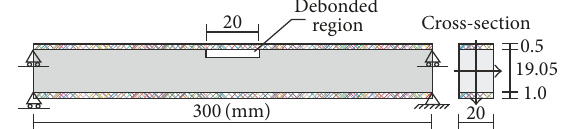
Figure 9: A debonded sandwich beam with foam core